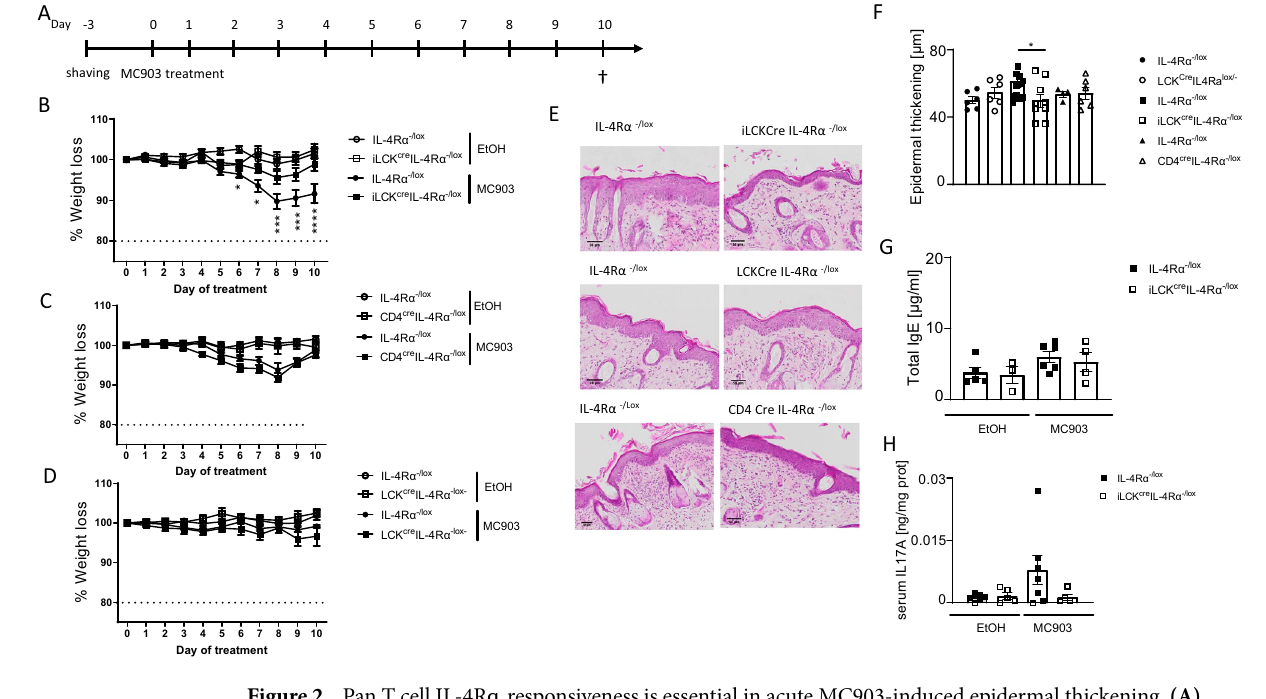
Figure 2. Pan T cell IL-4R ⍺ responsiveness is essential in acute MC903-induced epidermal thickening. (A) Mice were shaved at −3 days before treatment with Ethanol or 45 µM MC903 for 9 consecutive days. ( B ) Weight loss in IL-4R ⍺ −/lox and iLCK cre IL-4R ⍺ −/lox mice. ( C ) Weight loss in IL-4R ⍺ −/lox and CD4 cre IL-4R ⍺ −/lox mice. ( D ) Weight loss in IL-4R ⍺ −/lox and LCK cre IL-4R ⍺ −/lox mice. ( E ) H&E-stained images showing epidermal thickening, scale bar 50 μm. ( F ) Epidermal thickening using QuPath software, ( G ) Total IgE serum levels. ( H ) IL-17A serum levels. Shown is one representative experiment of 2 with mean ± SD. Statistical analysis was performed using Two-way ANOVA with Bonferroni post-test ( B–D ) or Student t-test Mann–Whitney ( F–H ) where *p < 0.05, **p < 0.01, ***p > 0.001, ****p > 0.0001 between IL-4Rα –/lox vs iLCK cre IL-4Rα –/lox MC903 treated mice. n = 5–8 mice per